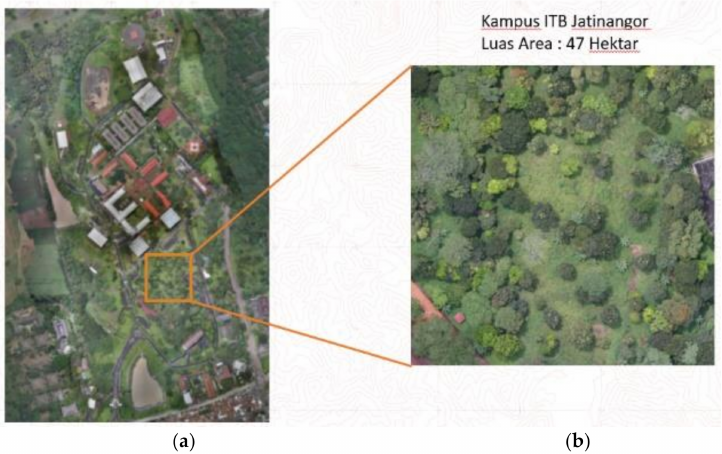
Figure 1. ( a ) The orthophoto of ITB Jatinangor Campus and ( b ) the modeling area of interest.